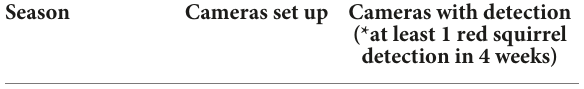
TABLE 2 Detection histories of camera trap survey data